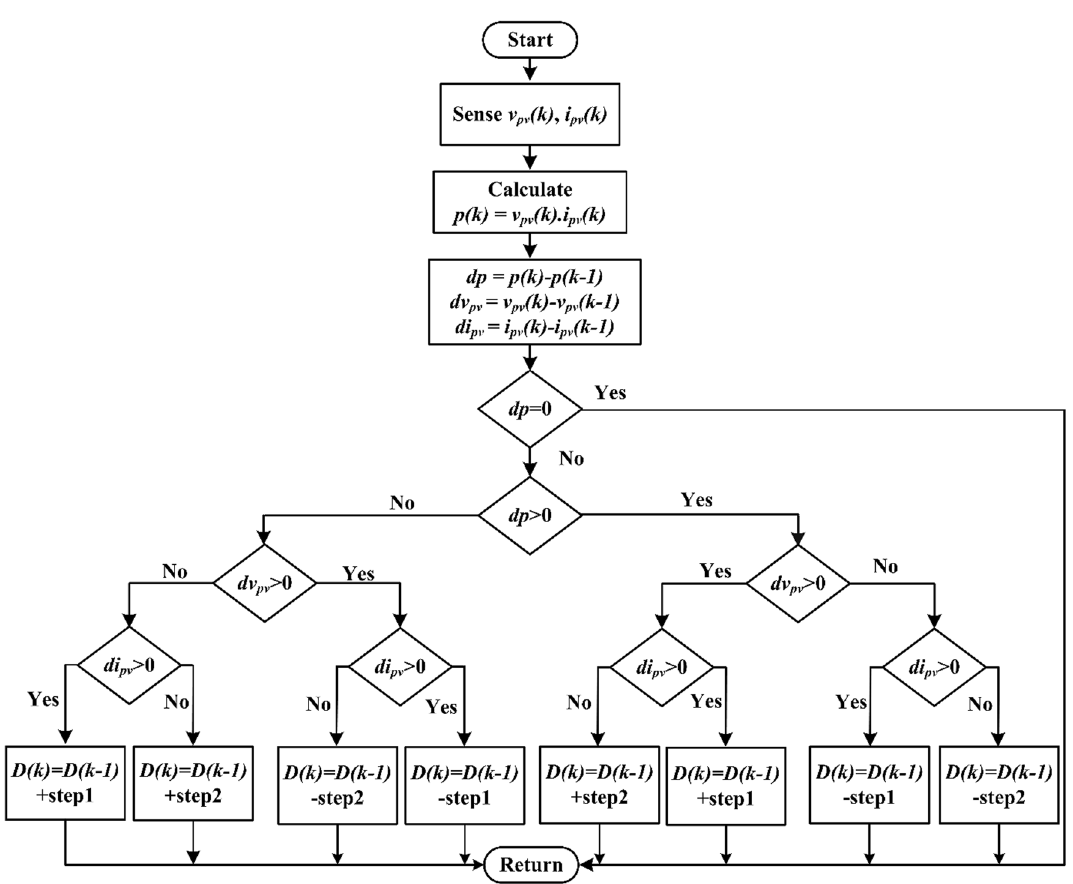
Fig. 7 Flowchart of VSPO